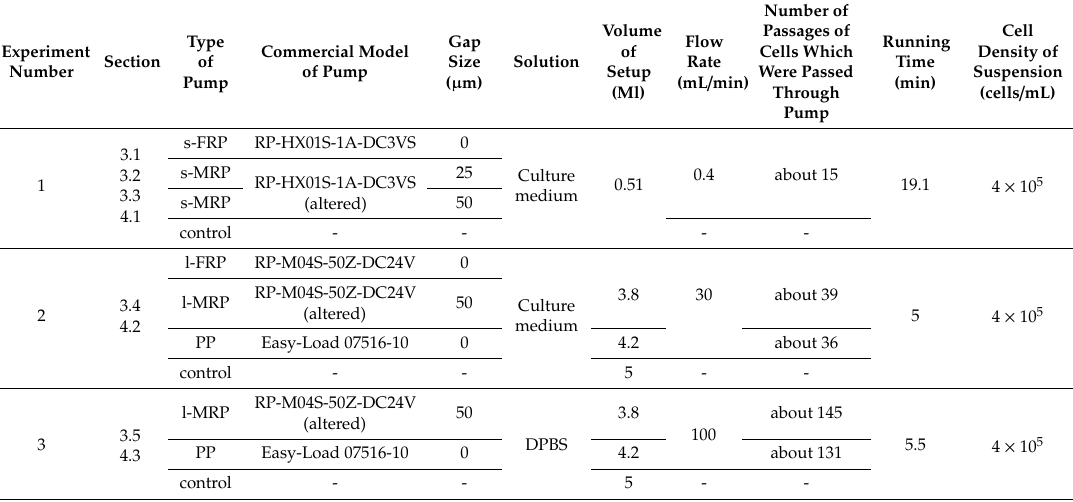
Table 2. Correspondence table between pumps and experimental